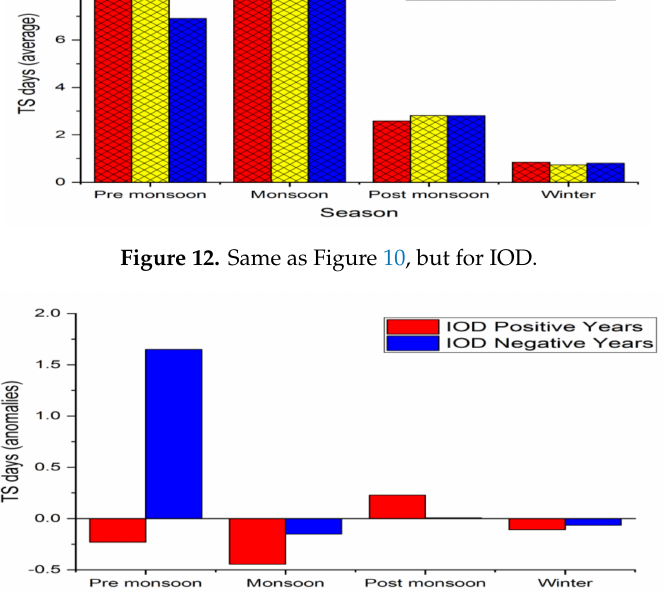
Figure 13. Same as Figure 11, but for